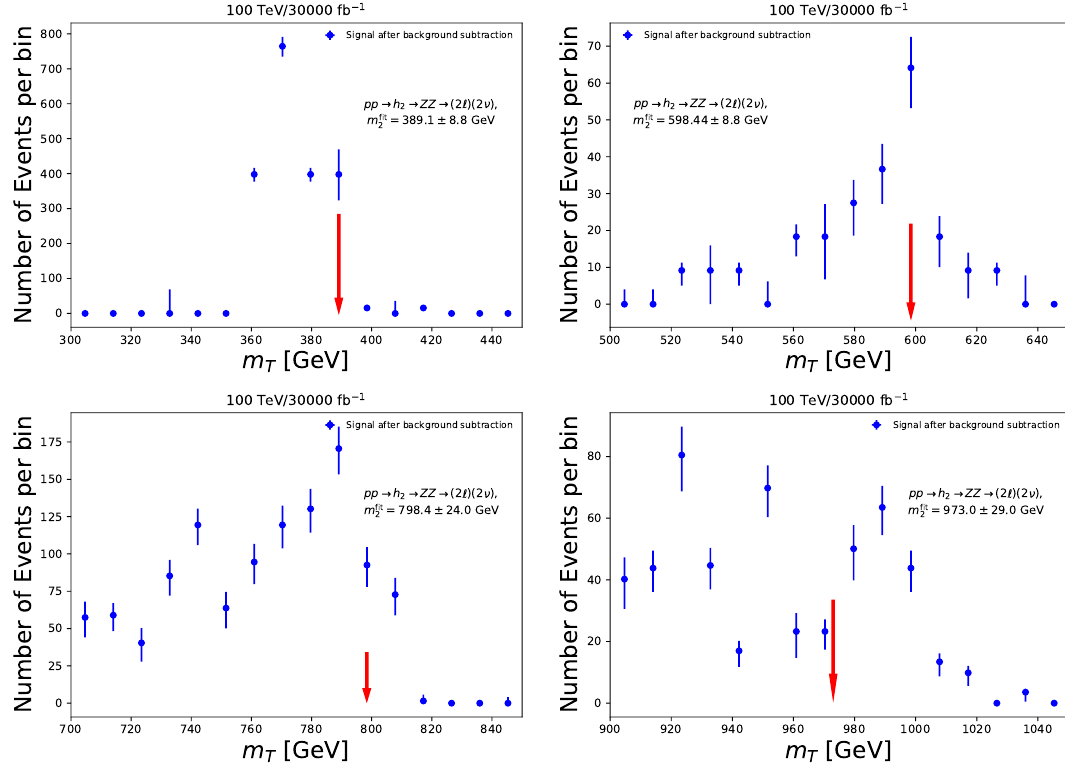
Figure 3 . A selection of results obtained through the mass determination procedure outlined in the main text is shown. We show the fits for cross sections corresponding to significances of Σ ’ 10 in the pp → ZZ → ( ‘ + ‘ − )( νν ) channel at a 100 TeV collider with an integrated luminosity of 30 ab − 1 , for real masses m = 400 , 600 , 800 , 1000 GeV corresponding to top left, top right, lower left and 2 lower right. The blue error bars represent the expected number of signal events in each bin. The red arrow shoes the determined value of the mass m . The uncertainty on the resulting mass fit is 2 determined by a combination of the bin width and the statistical